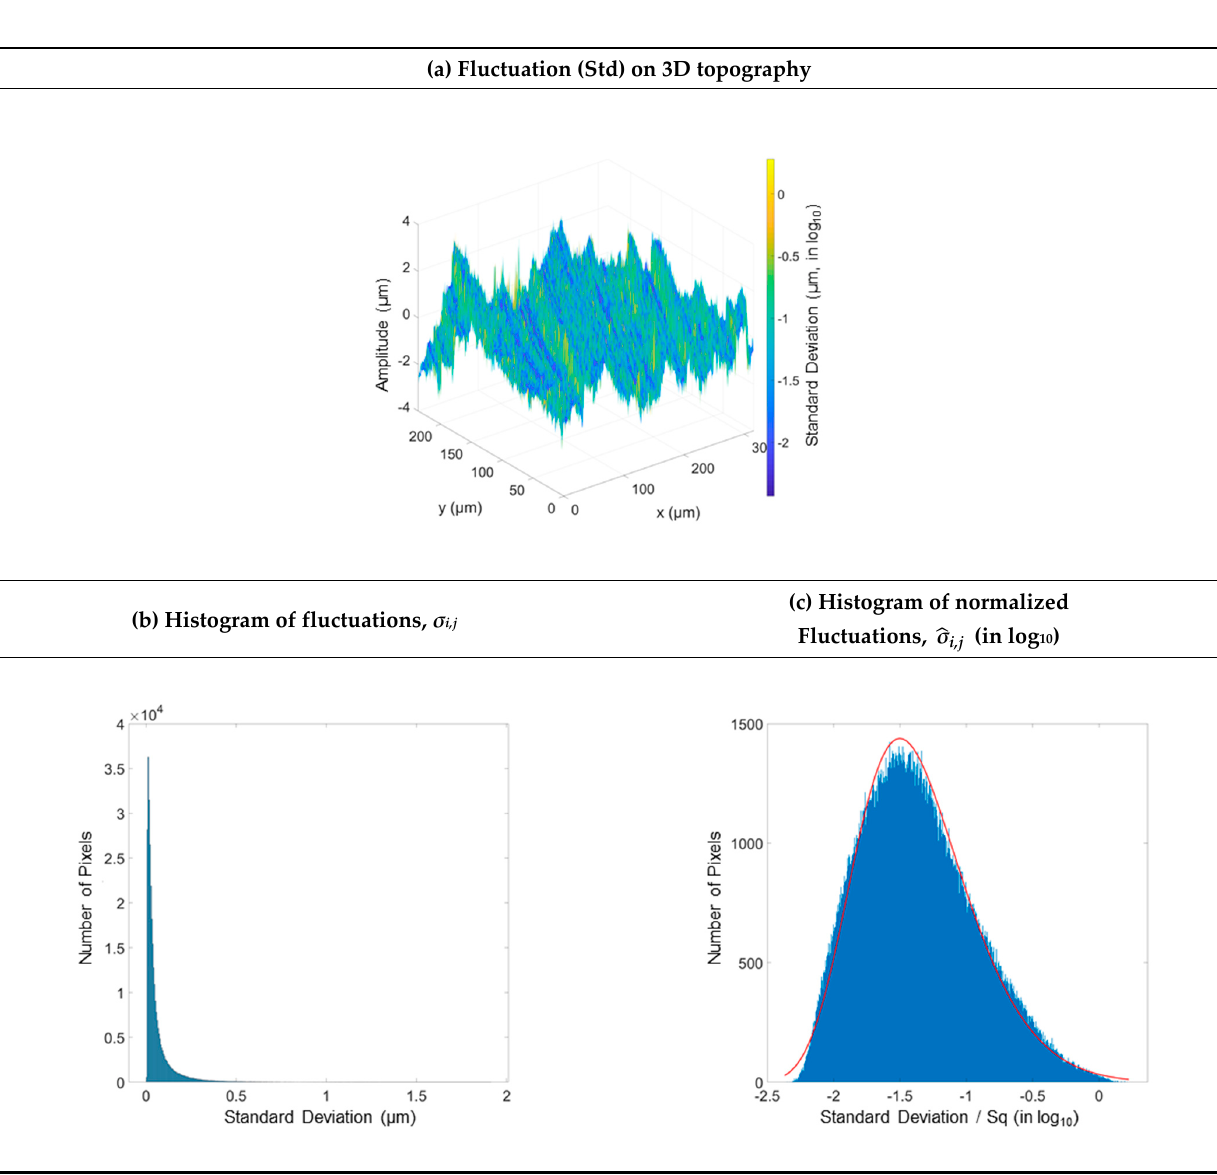
Figure 6 . Fluctuations projected on the 3D turned surface topography ( a ), associated histogram of fluctuations σ i,j ( b ), and histogram of normalized fluctuations σ (cid:3548) i,j ( c ). fluctuations σ i,j ( b ), and histogram of normalized fluctuations ˆ σ i , j ( c On a histogram of σ i,j (Figure 6b), fluctuations cover a range from 0.004 to 1.9 µm. indicates that fluctuations on real topographies do not always follow Gaussian distribu-